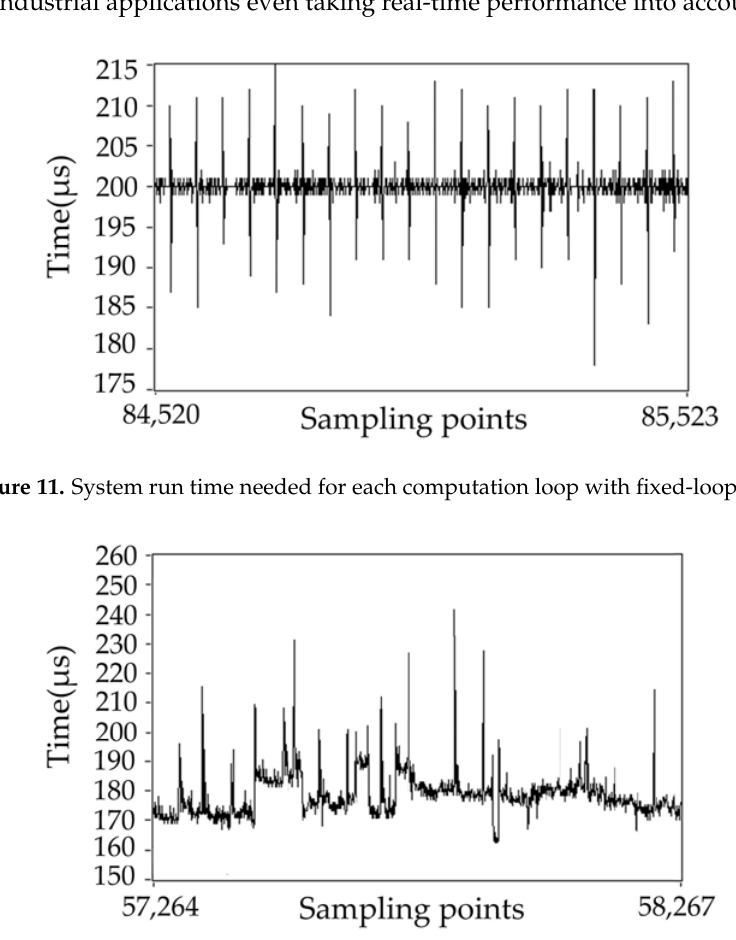
Figure 12. System run time needed for each computation loop with free ‐ loop ‐ time.